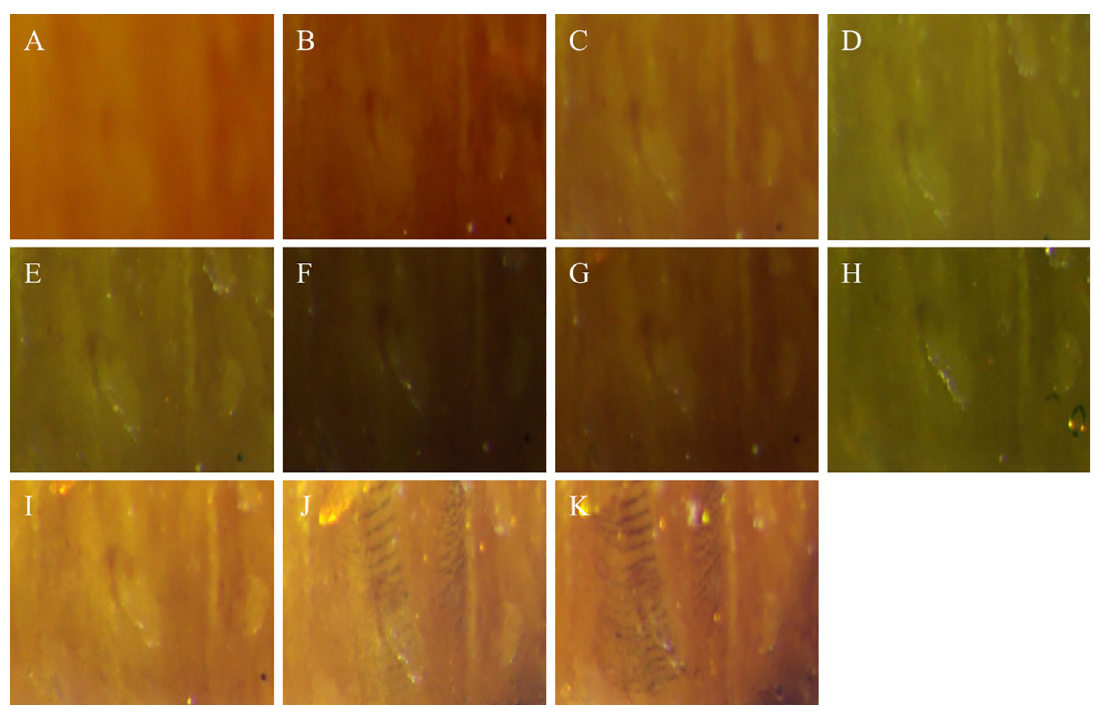
Fig 2. Enlarged view of area 17 of pupal image. Note: Fig 2A–2K respectively represent the changes of pupae characteristics from day 1 to day 11 in grid